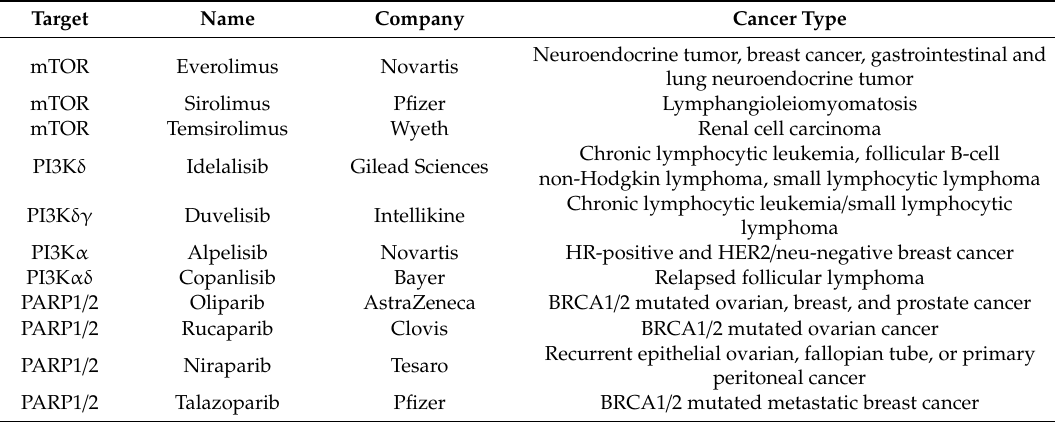
Table 1. Food and drug administration (FDA) approved inhibitors of enzymes relevant for the PARP-Akt